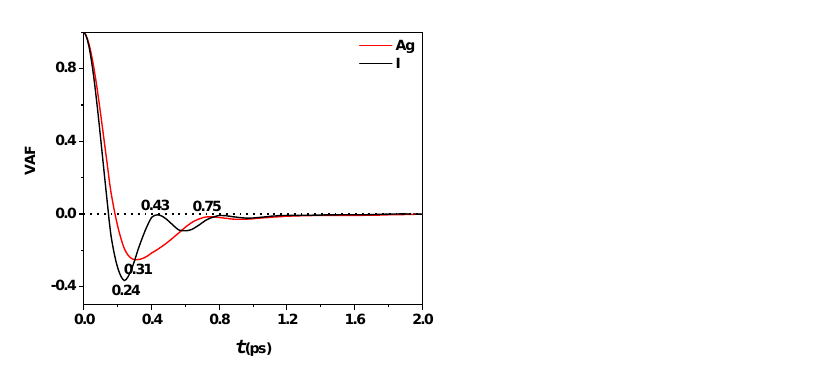
Figure 6. VAF for Ag (red line) and I (black line) ions. The black line has a minimum at t = 0.24 ps, while the red line at t = 0.31 ps. After t = 0.5 ps, both curves oscillate around zero. Temperature 300